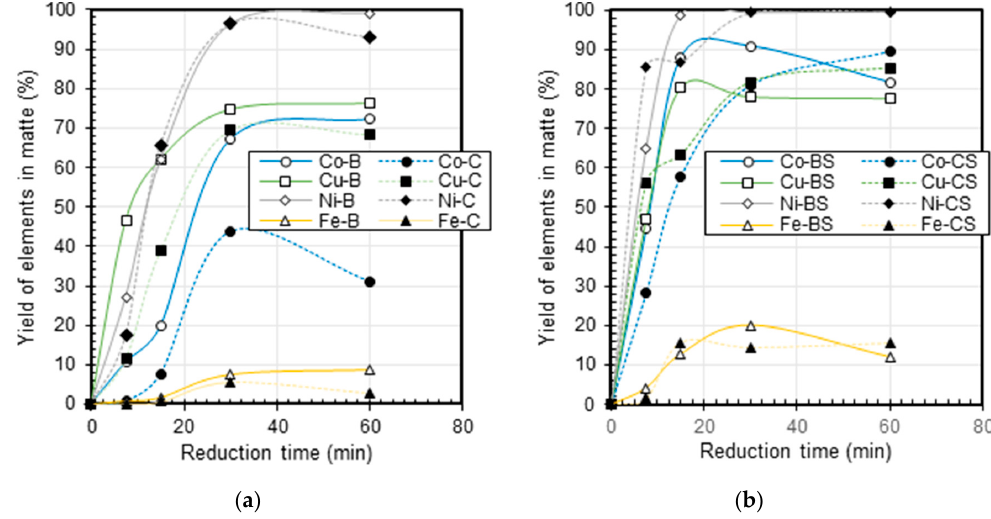
Figure 10. The metal value recoveries to matte phase in nickel slag reduction ( a ) yields with biochar (B) and coke (C); ( b ) yields with biochar, slag and battery scrap (BS) as well as coke, slag and battery scrap (CS).